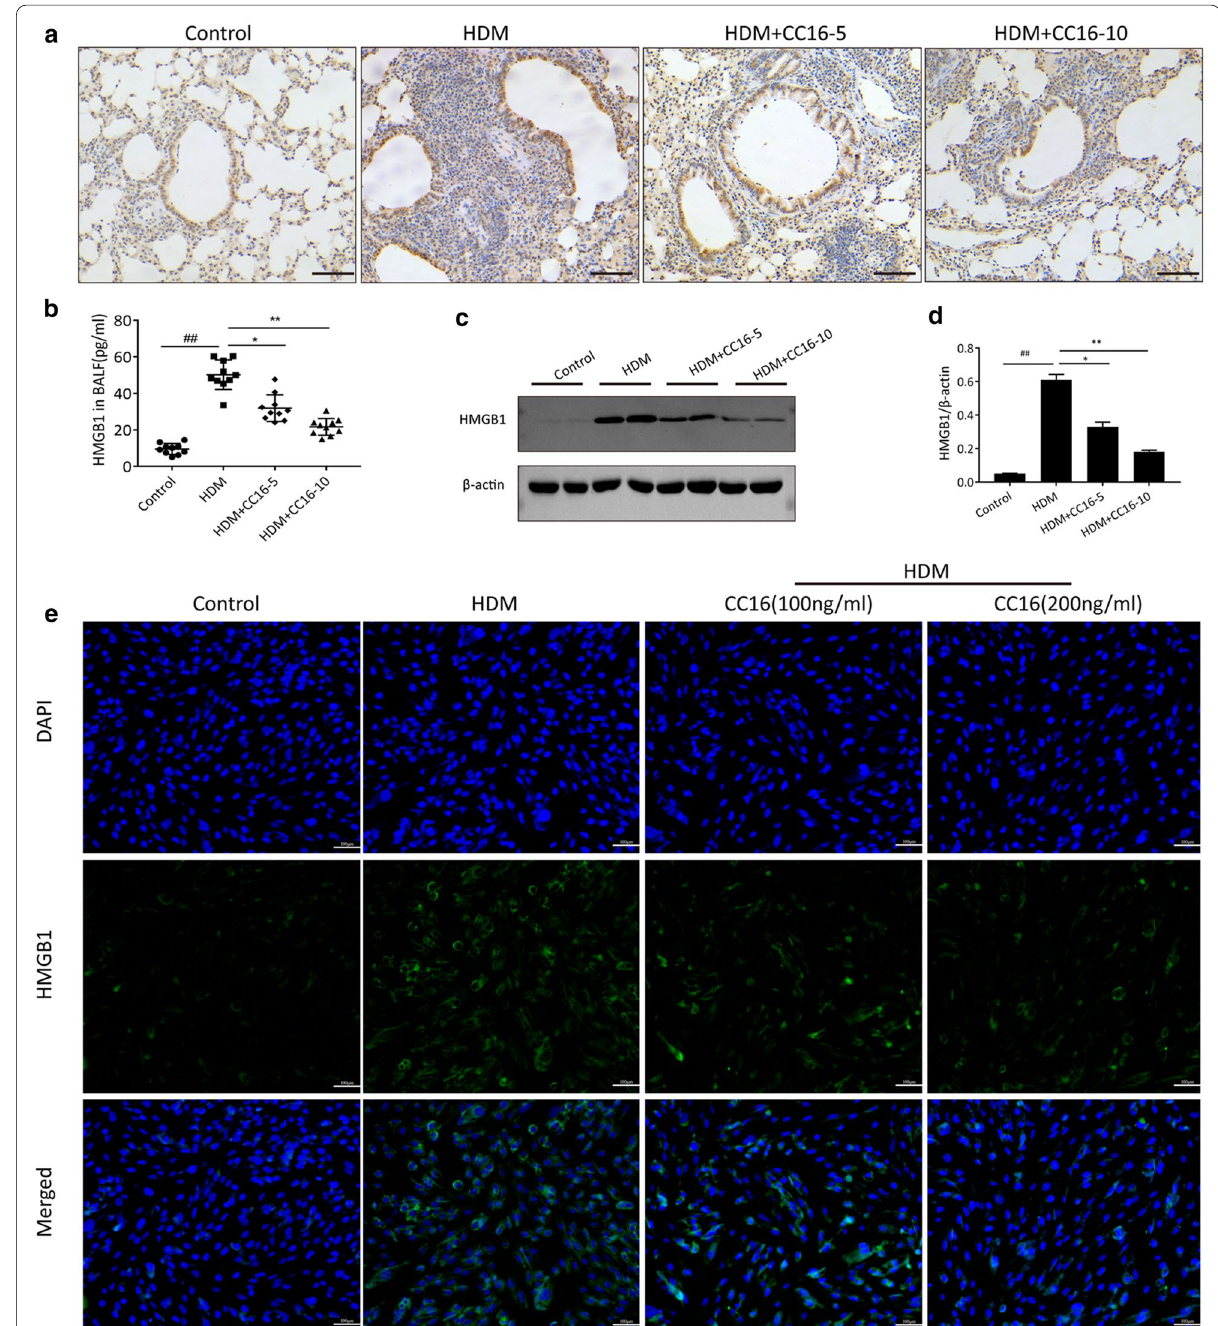
Fig. 4 CC16 treatment restrains HDM-induced upregulation of HMGB1 in vivo and in vitro. a Representative immunohistochemistry images of HMGB1 expression in airway epithelium after different treatments. Scale bar 100 μm. b The BALF levels of HMGB1 were determined by ELISA = among different groups. c Western blot was performed to examine HMGB1 expression in lung tissues of different groups. d Quantitation of the HMGB1/β-actin ratios. e Representative immunofluorescence images of HMGB1 (green) in BEAS-2B cells with different treatments. Scale bar 100 μm. Data are expressed as means SEM. ## p < 0.01 vs. Control group; *p < 0.05 vs. HDM group; **p < 0.01 vs. HDM = ±